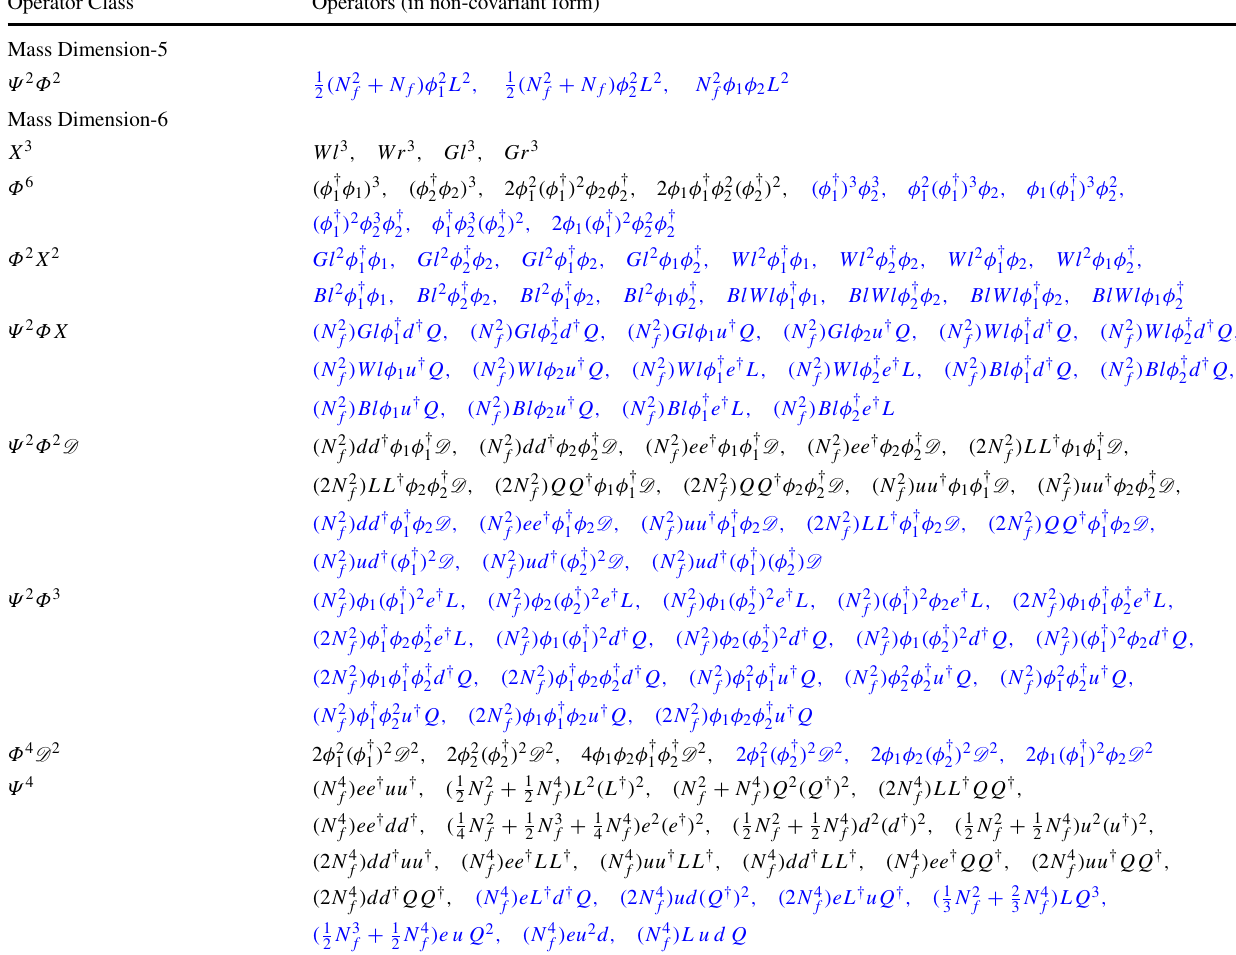
Table 5 2HDM: operators of mass dimensions-5 and -6